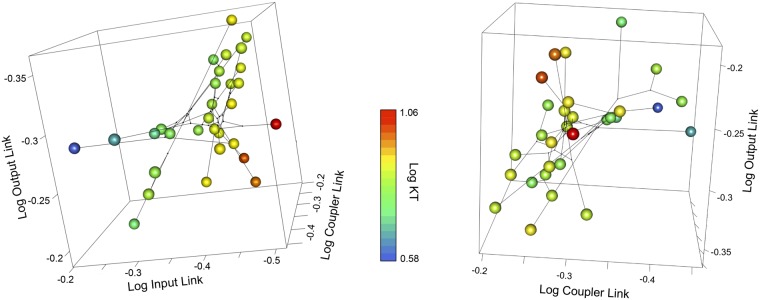
Mechanical sensitivity in the cichlid oral four-bar linkage system. Each plot is a 3D phylomorphospace showing variation in input link, output link, and coupler link length for 30 species of cichlid fish. Each point in the plots corresponds to a different cichlid species. The color of each point corresponds to the estimated maxillary KT of that species’ oral four-bar linkage. In the left panel, the strong mechanical sensitivity of maxillary KT to input link size is illustrated (note color gradient from blue to red). In the right panel, the lack of sensitivity with regard to the output and coupler links is illustrated (no color gradient). Original data: Hulsey and García De León 2005. Phylogeny: Hulsey et al. 2010. Phylomorphospace plots: Muñoz et al. 2018, supp. mat.